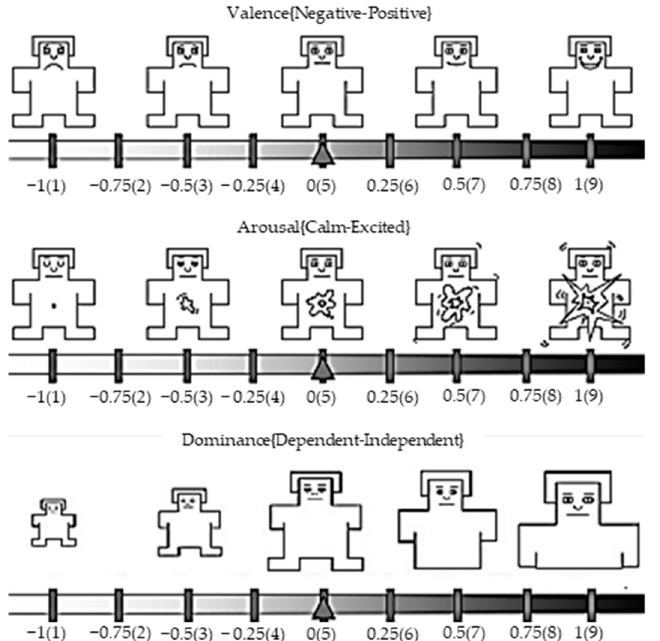
Figure 2. SAM (self-assessment manikin) scale. Adapted with permission from Ref. [15]. Copyright 1994 Peter Lang.